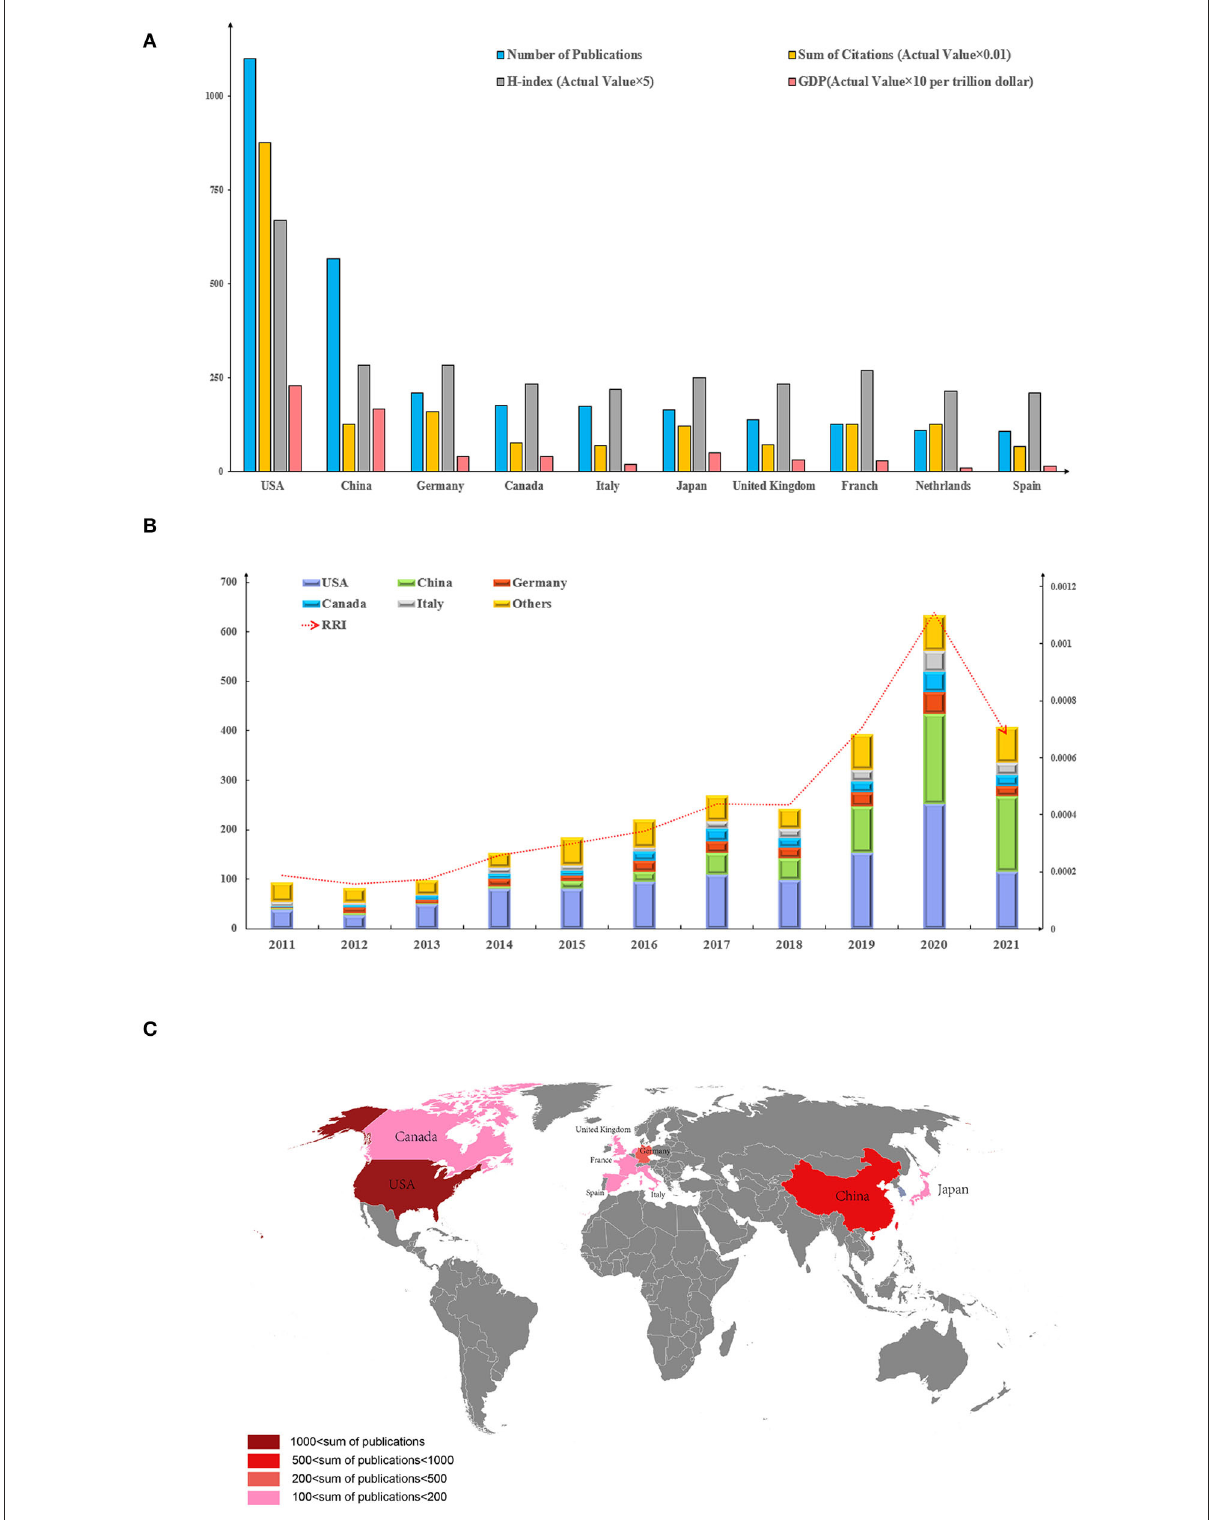
FIGURE3 Contributions of different countries/regions to research on gut microbiota and host immune response. (A) Number of publications, sum of citations (Actual Value × 0.01), H-index (Actual Value × 5), and GDP (Actual Value × 10 per trillion dollar) in the top 10 countries or regions; (B) Number of publications worldwide and the time course of the RRI in gut microbiota and host immune response; and (C) Regional clustering characteristics of